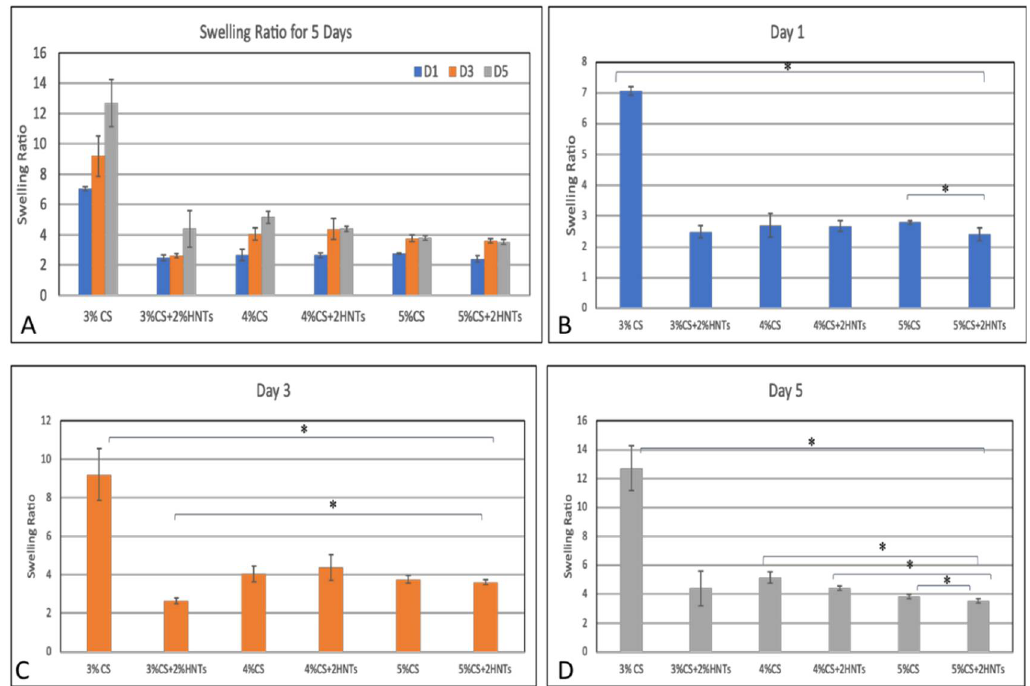
Figure 5. Swelling ratio for each hydrogel. The overall changes are presented in summary figure ( A ). The swelling ratio for Day 1, Day 3 and Day 5 ( B – D , respectively). The symbol * indicates a significant difference ( p < 0.05, n = 3). Error bar represents standard deviation.